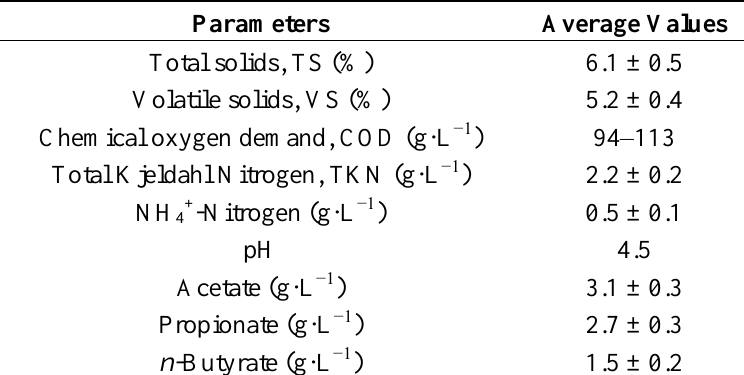
Table 1. Composition of biowaste